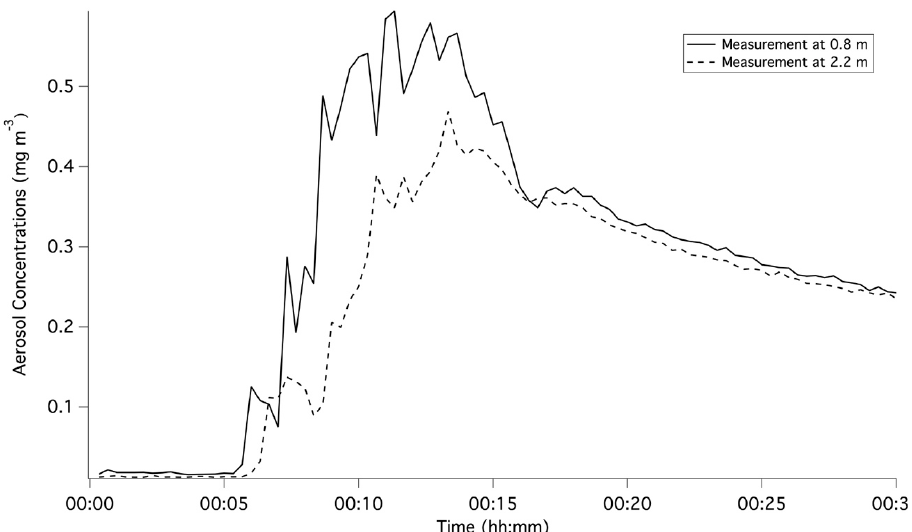
Figure 2. Comparison of time-series averaged aerosol concentrations for the three runs with a gas-flow rate of 10 L/min at two distances using the tracheostomy interface for a simulated adult.